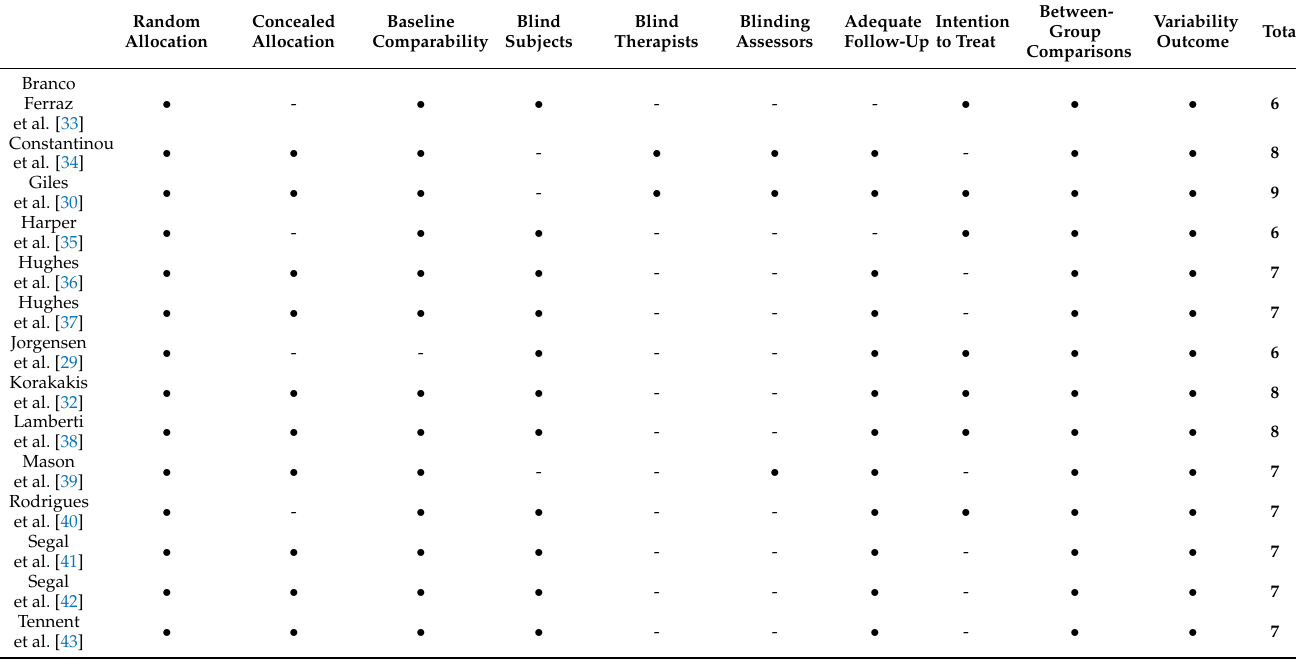
Table 1. Results of the internal assessment of the documents selected according to the PEDro